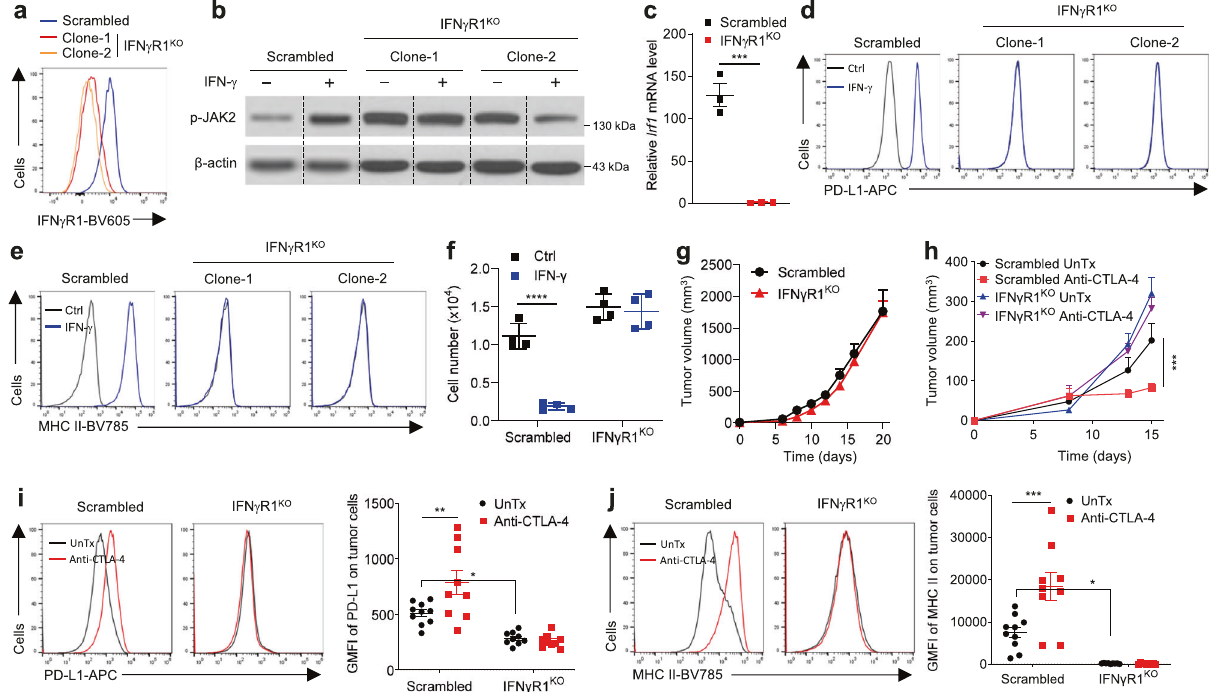
Fig. 1 | Generation and characterization of IFN γ R1 KO melanoma model lacking functional IFN- γ signaling. B16-BL6 cells were transduced with speci fi c single guide RNAs (sgRNAs) against exon #1 of mouse Ifngr1 or scrambled sgRNAs. a IFN γ R1 expression in scrambled control and IFN γ R1 KO clones by fl ow cytometry (FACS strategy 1). b p-JAK2 in scrambled control and IFN γ R1 KO clones untreated (UnTx)ortreatedwithIFN- γ (100U/mLfor15min)byWesternblot. β -actinwasthe loading control. Experiments were repeated twice with similar results. c mRNA expression of Irf1 in scrambled control ( n =3) and IFN γ R1 KO cells ( n =3) treated with 1000U/mL of IFN- γ for 90min. *** p =0.0007 by two-sided Student ’ s t